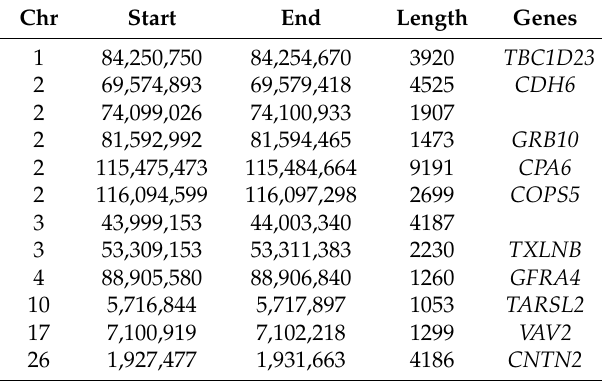
Table 1. Twelve specific CNV segments in Line 72 as compared to other